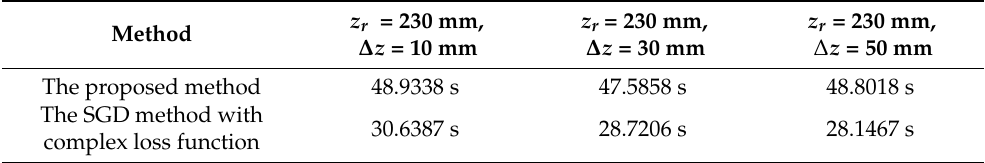
Table 1. Comparison of the optimization time for 100